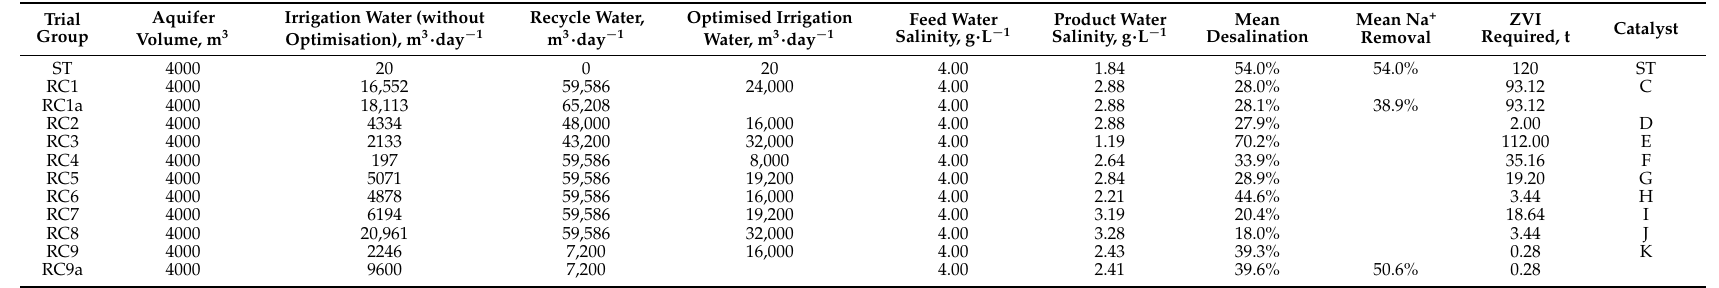
Table F1. Expected Performance of a semi-confined schematic Aquifer Treatment Zone containing 4000 m 3 of water. The data values (and scaled volumes) are based on trial observations (Figures B2 and C5, Table E1). The aquifer volumes and feed water salinities have been normalized to demonstrate the operational differences between the catalysts. The duration of all the sub-optimized trials was extended beyond the initial appearance of B S . Optimized irrigation water production rates assume that t d approximates to the start of B S . Catalyst ST* is a Type A Catalyst . Catalysts C to K are Type B Catalysts . ZVI required is based on trial data and has not been